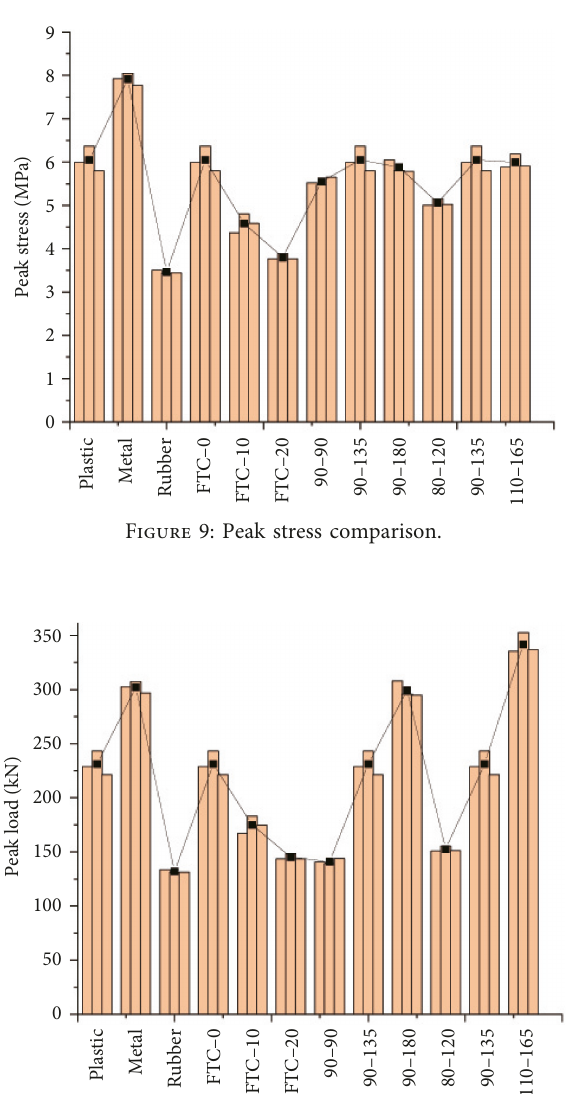
Figure 10: Peak load